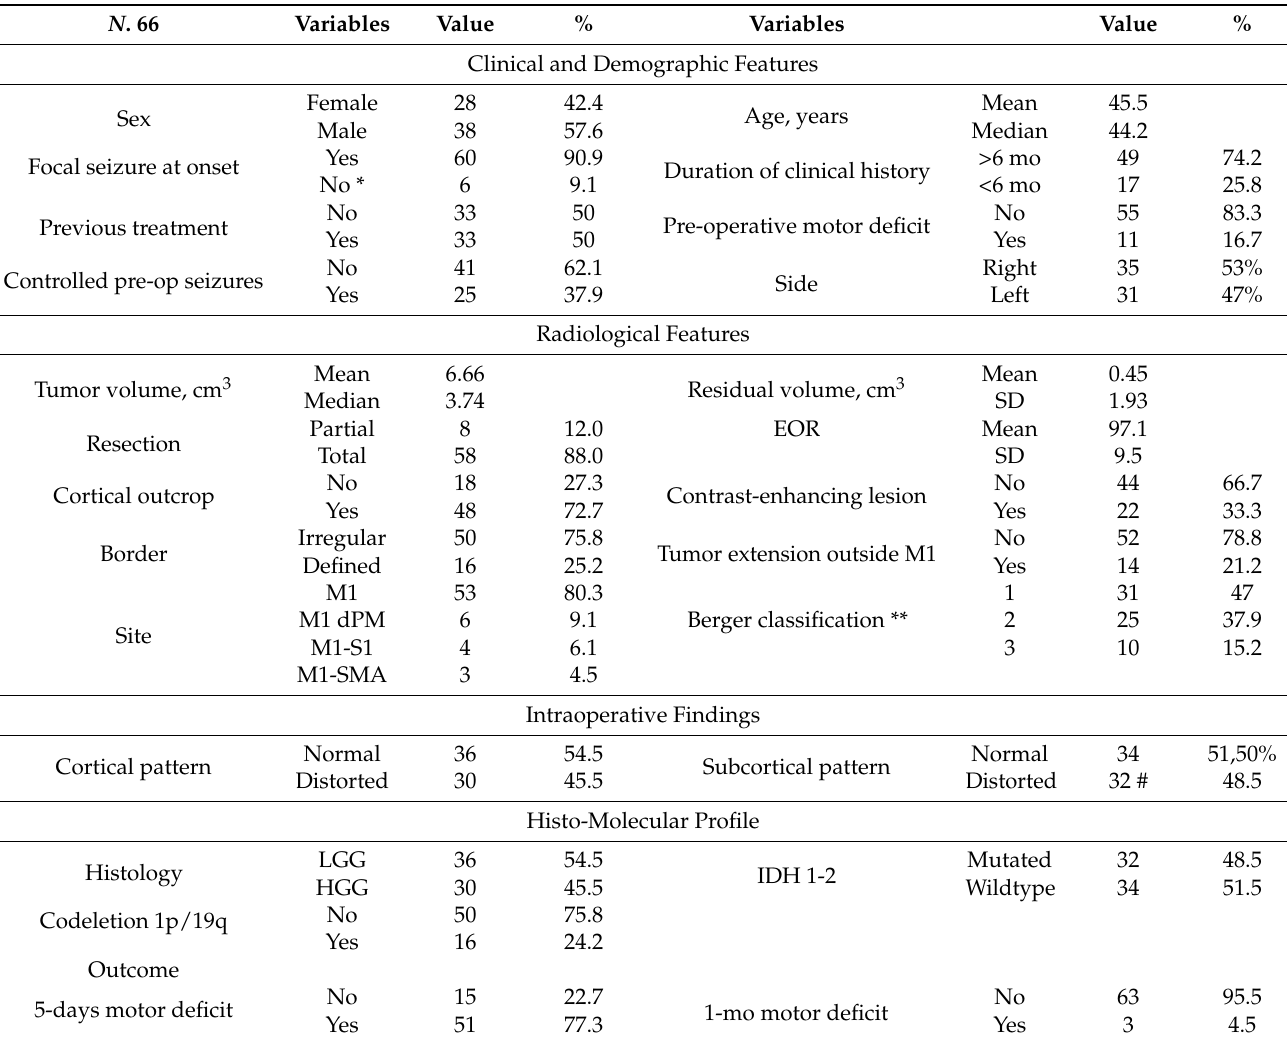
Table 1. Clinical, imaging, intraoperative and post-operative findings in the 66 patients with a tumor within M1. N .